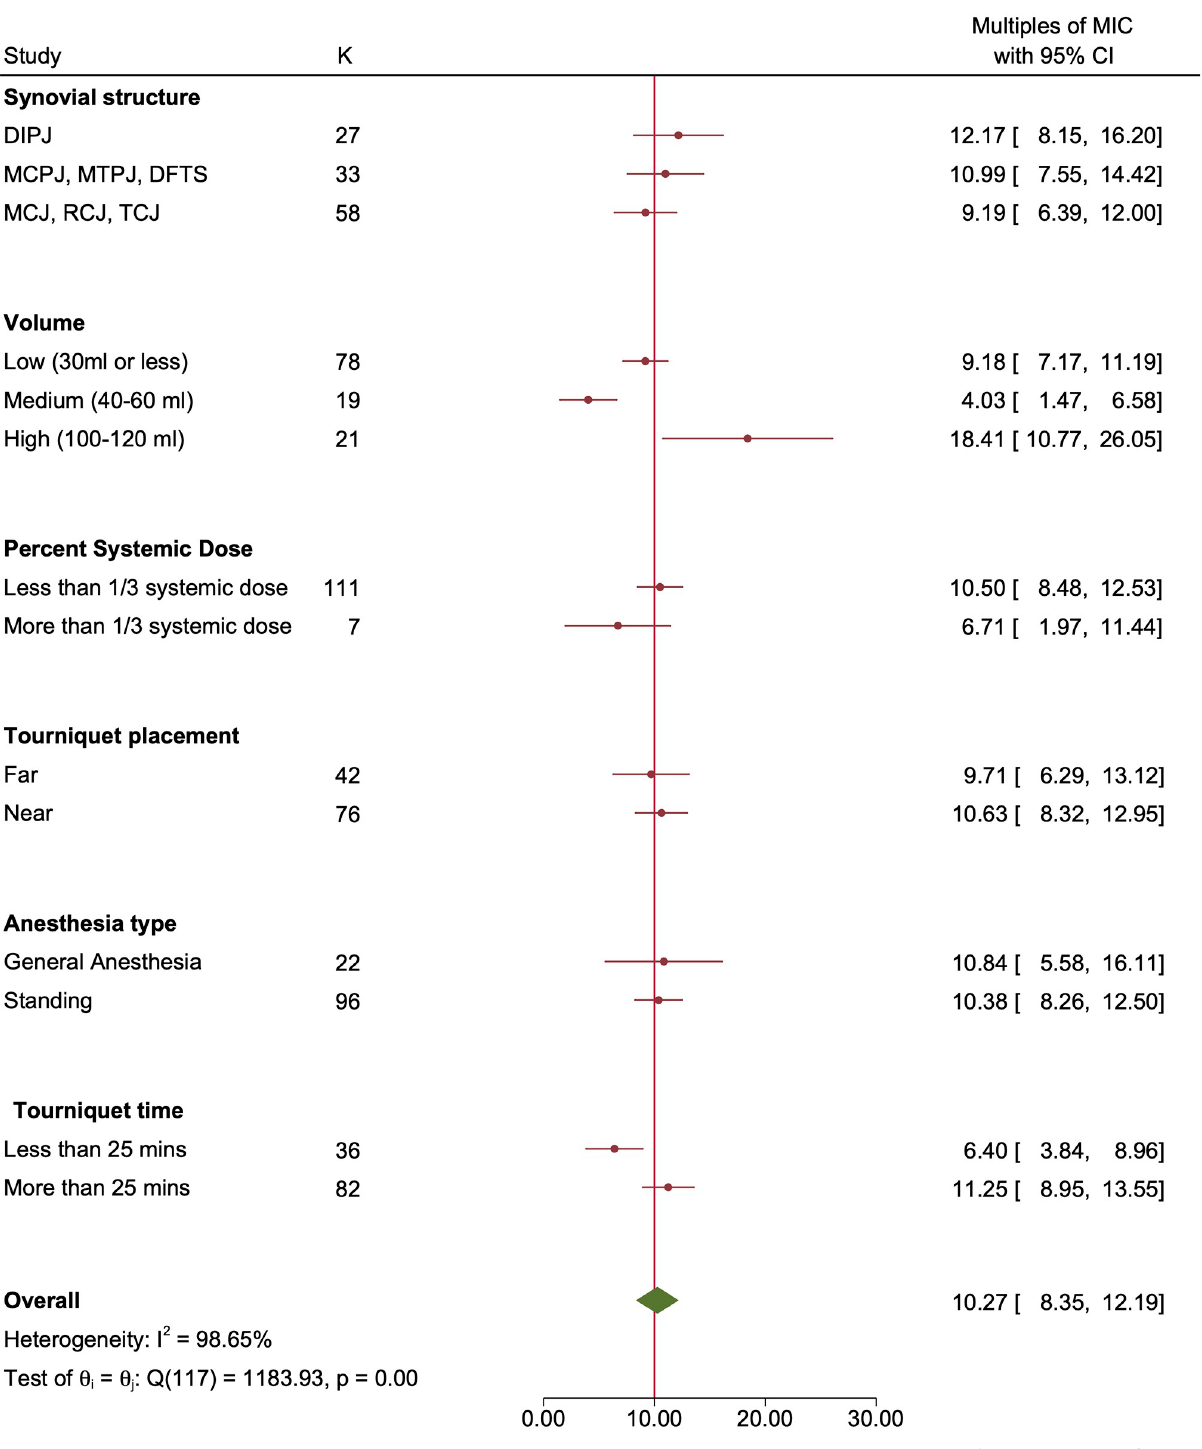
Fig 5. Forest plot by subgroups with variables for which there were no statistically significant differences in outcome. The concentrations of antibiotics achieved in the synovial structure (multiples of the MIC) for resistant bacteria are shown. The vertical red line represents 10x MIC. Red circles represent point estimates, red horizontal lines represent 95% confidence intervals. The green diamond represents the summary measure θ , but this measure is not considered reliable due to the high heterogeneity between studies.